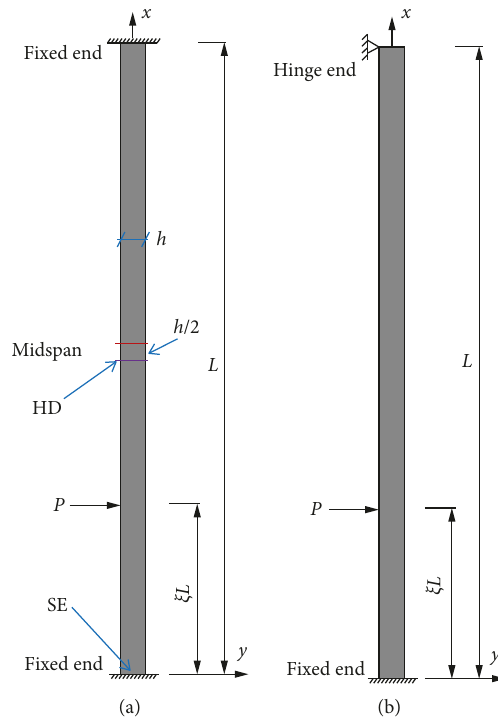
Figure 1: Different boundary conditions for the bridge